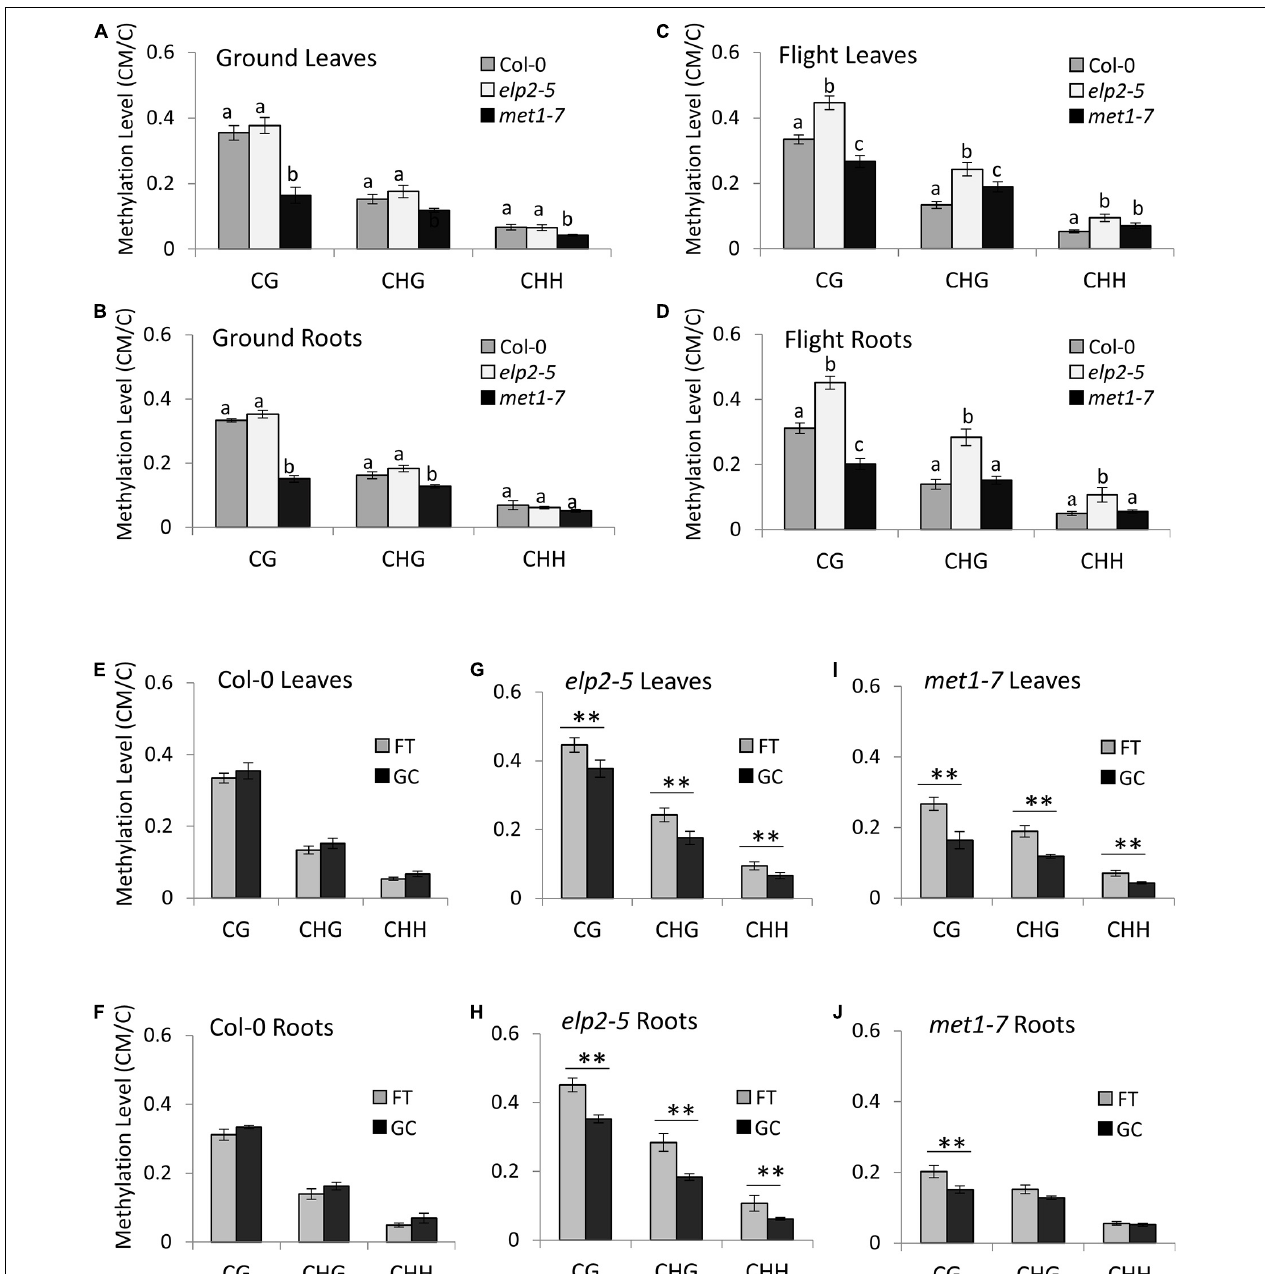
FIGURE 2 | Average genome-wide methylation level profiles in spaceflight and on the ground. (A–D) A comparison of the average genome-wide methylation levels (CG, CHG, and CHH) across the three genotypes is illustrated in leaves grown on the ground (A) , roots grown on the ground (B) , leaves grown in spaceflight (C) , and roots grown in spaceflight (D) . Statistical analyses were performed using two-sample t- test with Bonferroni corrections. Bar graphs with different letters show significant differences ( p < 0.01). In addition, Two-Factor ANOVA analyses with replication showed that the relationships between methylation contexts were dependent on the samples ( p < 1.0E-10). (E–J) Average genome-wide methylation levels are shown of each genotype (Col-0 wild-type, elp2 , and met1-7 ) and tissue type (leaves or roots) in spaceflight (FT) and ground controls (GC). Data represent the mean of four independent samples and ∗∗ indicate significance ( p < 0.01, two-sample t- test with Bonferroni corrections) difference between flight and ground controls in each of the methylation contexts (CG, CHG, and